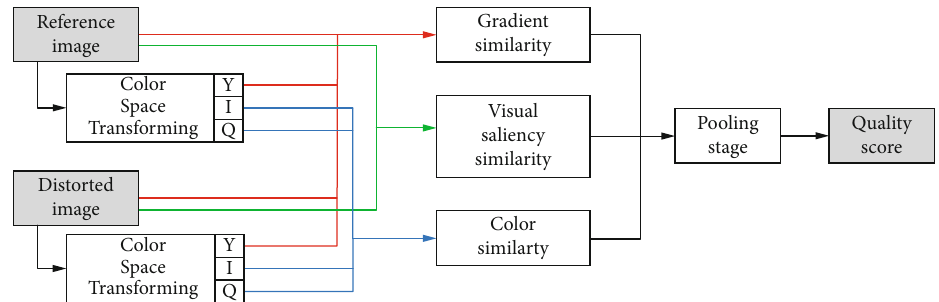
Figure 1: The proposed IQE model framework based on local GS, CS, and